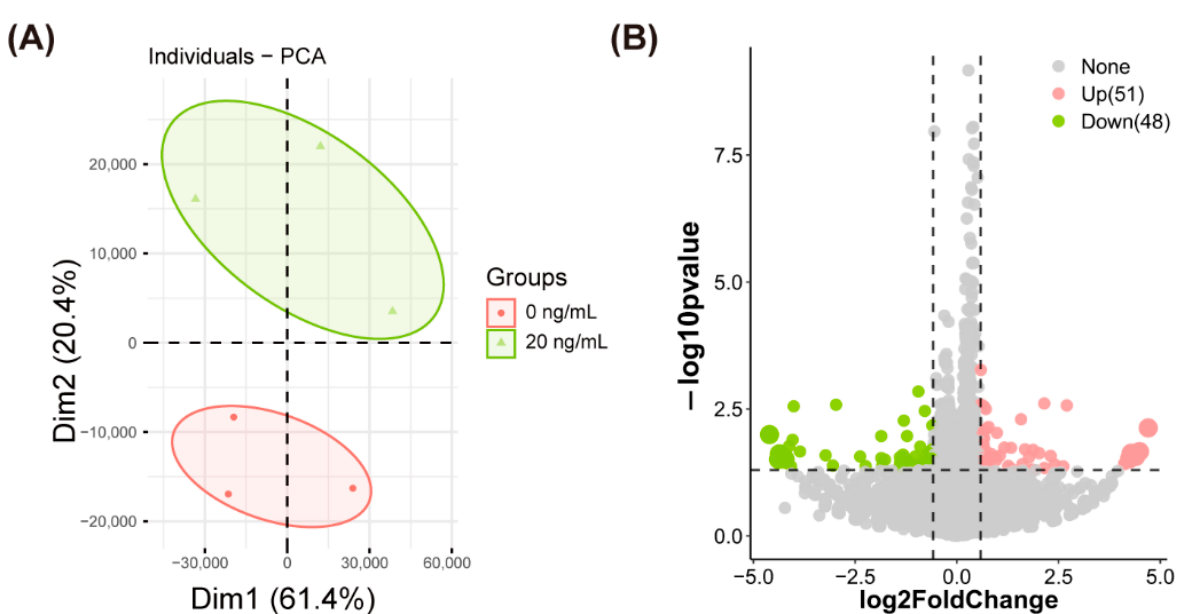
Figure 5. ( A ) Principal component analysis (PCA) of sequenced pig matured oocytes in vitro samples from control and 20 ng/mL SDF1-treated groups and ( B ) volcano plot of differentially expressed genes between two groups.